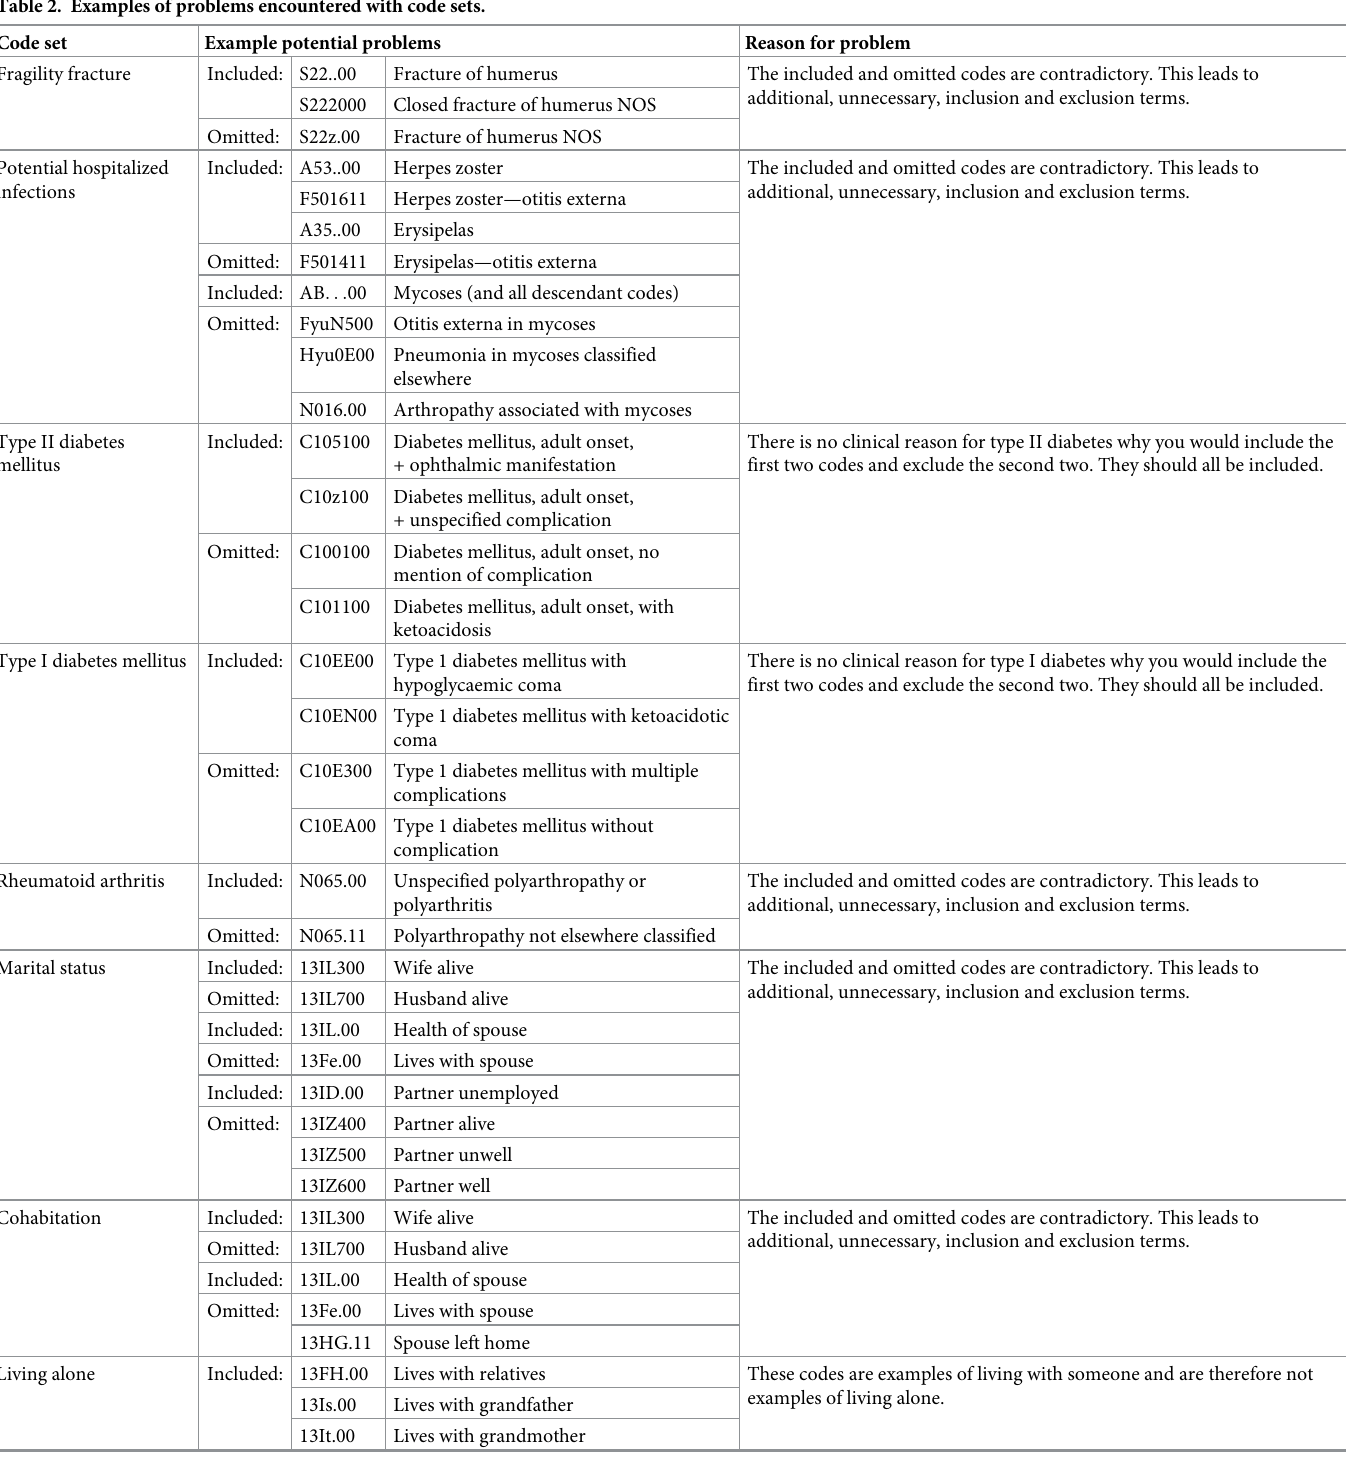
Table 2. Examples of problems encountered with code sets. Code